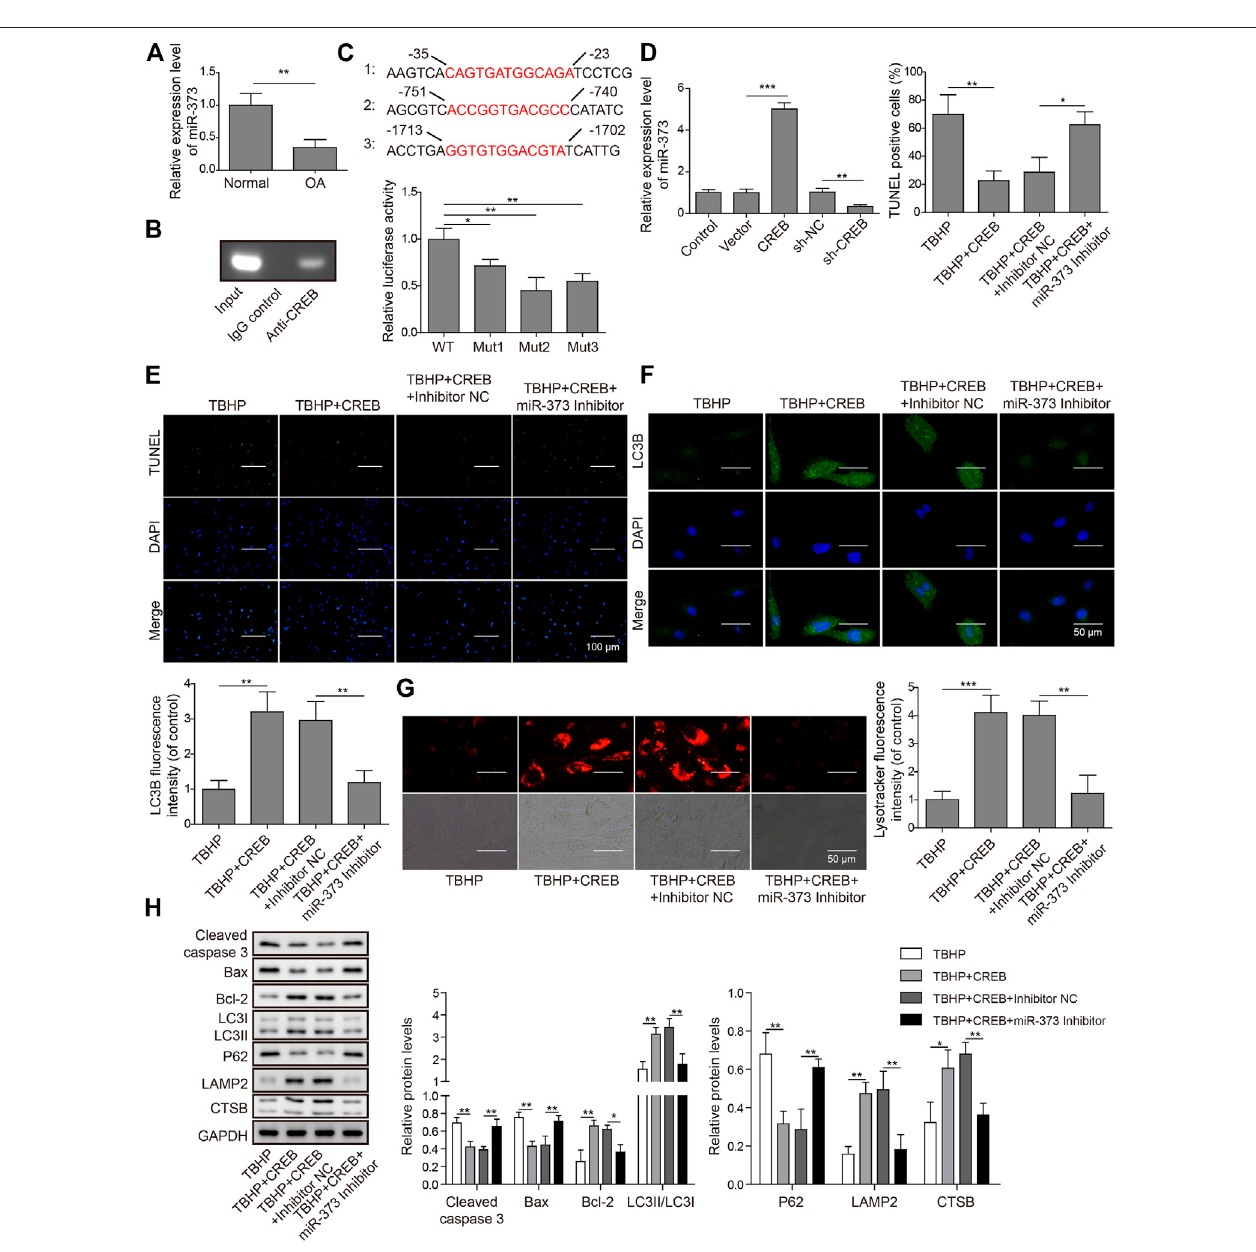
FIGURE 3 | CREB regulated apoptosis and autophagic fl ux through miR-373. (A) The expression of miR-373 in normal and OA human cartilage tissues was determined by qRT-PCR. (B) The binding of CREB at the miR-373 promoter was determined by ChIP assay. (C) A schematic diagram of CREB binding domain on the miR-373 promoter. The promoting activity of CREB to different mutated miR-373 promoters was measured by luciferase reporter assay. The signal data from each groupwerenormalizedtoWTtogeneratethecolumnchart. (D) ChondrocytesweretransfectedwithorwithoutCREB-overexpressedvectors(oremptyvectors)or sh-CREB (or sh-NC). The expression of miR-373 after transfection was measured by qRT-PCR. (E) The effect of miR-373 inhibitor on apoptosis under CREB overexpression was determined by TUNEL assay. The TUNEL-positive cells were numbered to generate the column chart. (F) The effect of miR-373 inhibitor on the CREB-promotedautophagic fl uxintheTBHP-induced invitro OAmodelwasdeterminedbytheimmunocyto- fl uorescencestainingofautophagosomemarkerLC3B.To generate the column chart, LC3B fl uorescence intensity was measured and data from all groups were normalized to the TBHP group. (G) The change of lysosome activity in the same model was determined by LysoTracker staining. LysoTracker fl uorescence intensity was measured and data from all groups were normalized to the TBHPgroup. (H) TheimpactofthetreatmentsontheessentialregulatorsormarkersofapoptosisandautolysosomewasdeterminedbyWesternblotting.Thequanti fi ed intensity of the bands was normalized to GAPDH to generate the column chart. p < 0.05 was marked as *, p < 0.01 was marked as **, p < 0.001 was marked as ***.